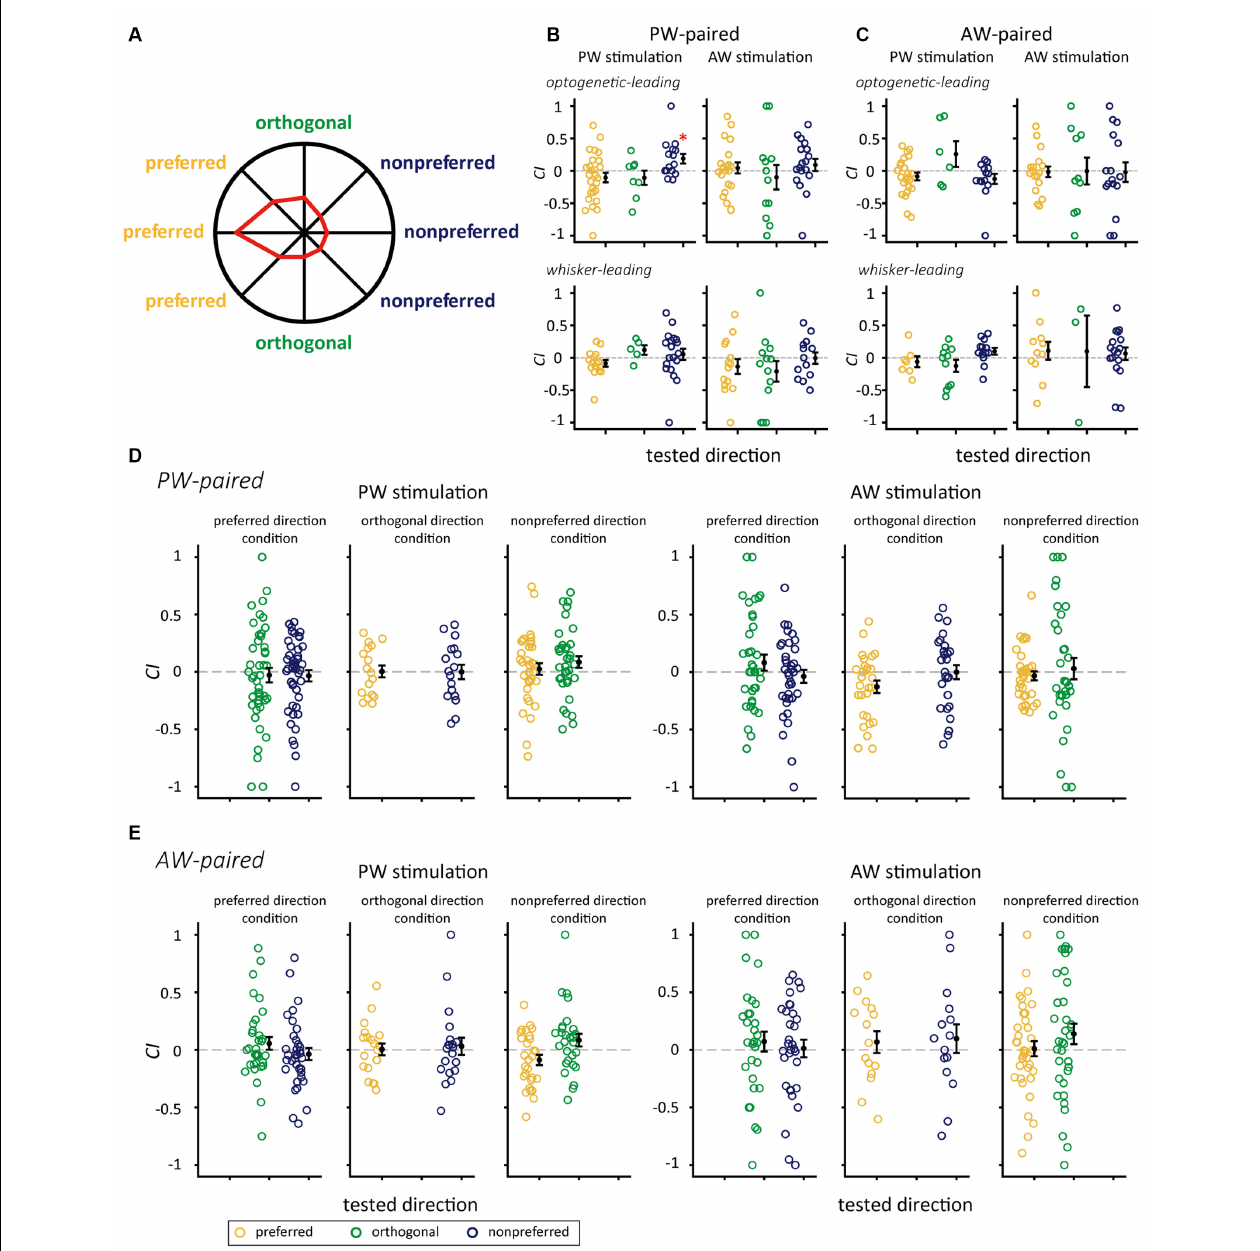
FIGURE 5 | The interaction between paired directions and SOAs on CI s for the PW-paired and AW-paired groups. (A) The polar plot of directional responses in the sample single unit with the preferred direction of 180 ◦ . The preferred, orthogonal, and nonpreferred directions were assigned with respect to its preferred direction. (B) The PW-paired group. After paired stimulation, CI s for PW increased when paired with the nonpreferred direction in the optogenetic-leading condition, while CI s for PW in the mechanical-leading condition and for AW were not altered in any conditions ( ∗ for p < 0.05/3, Wilcoxon signed-rank test, Bonferroni correction). (C) The AW-paired group. CI s were not altered in any conditions ( p > 0.05/3 in all conditions). Yellow, green, and blue circles indicate CI s for whisker stimulation in the preferred direction, orthogonal direction, and nonpreferred directions, respectively. (D) The PW-paired group. Left panel: CI s for PW stimulations in unpaired directions. Right panel: CI s for AW stimulations in unpaired directions ( p > 0.05/2 in all conditions). (E) The AW-paired group. Left panel: CI s for PW stimulations in unpaired directions. Left panel: CI s for AW stimulations in unpaired directions ( p > 0.05/2 in all conditions).